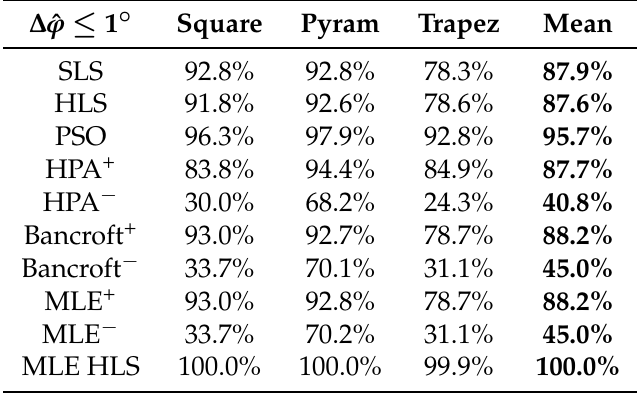
Table 4. Percentage of positions analysed located with an azimuth angle error ∆ ˆ ϕ lower than 1 ◦ under theoretical conditions for each algorithm and antenna array